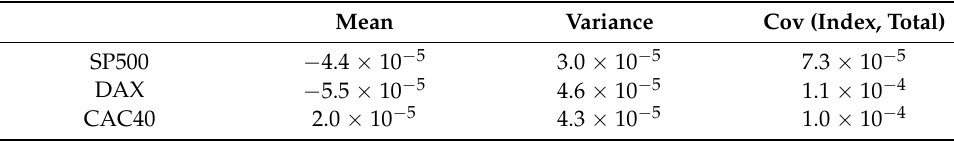
Table 1. Descriptive statistics for daily